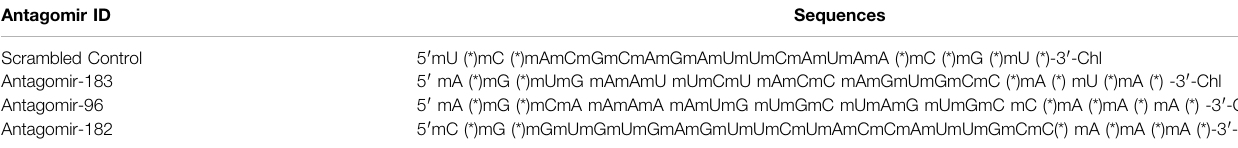
TABLE 1 | Scrambled control and speci fi c miR-183, -96, -182 antagomirs sequences. Antagomir